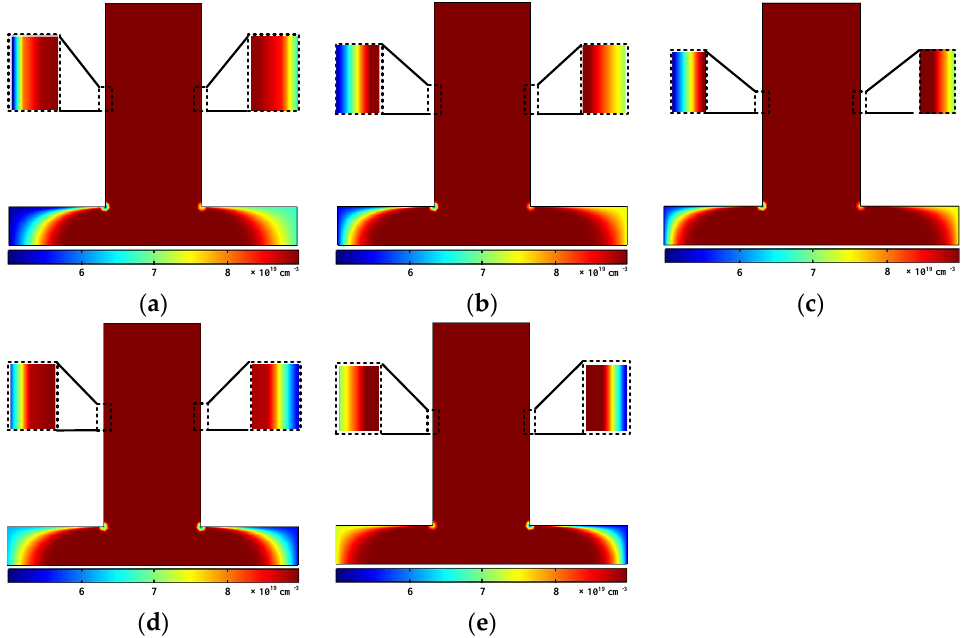
Figure 18. Spatial distribution of CO 2 density at time ( a ) 2 ms, ( b ) 6 ms, ( c ) 10 ms, ( d ) 14 ms, and ( e ) 18 ms for the reactor at AC 22 kV voltage and 1 cm distance between electrodes.